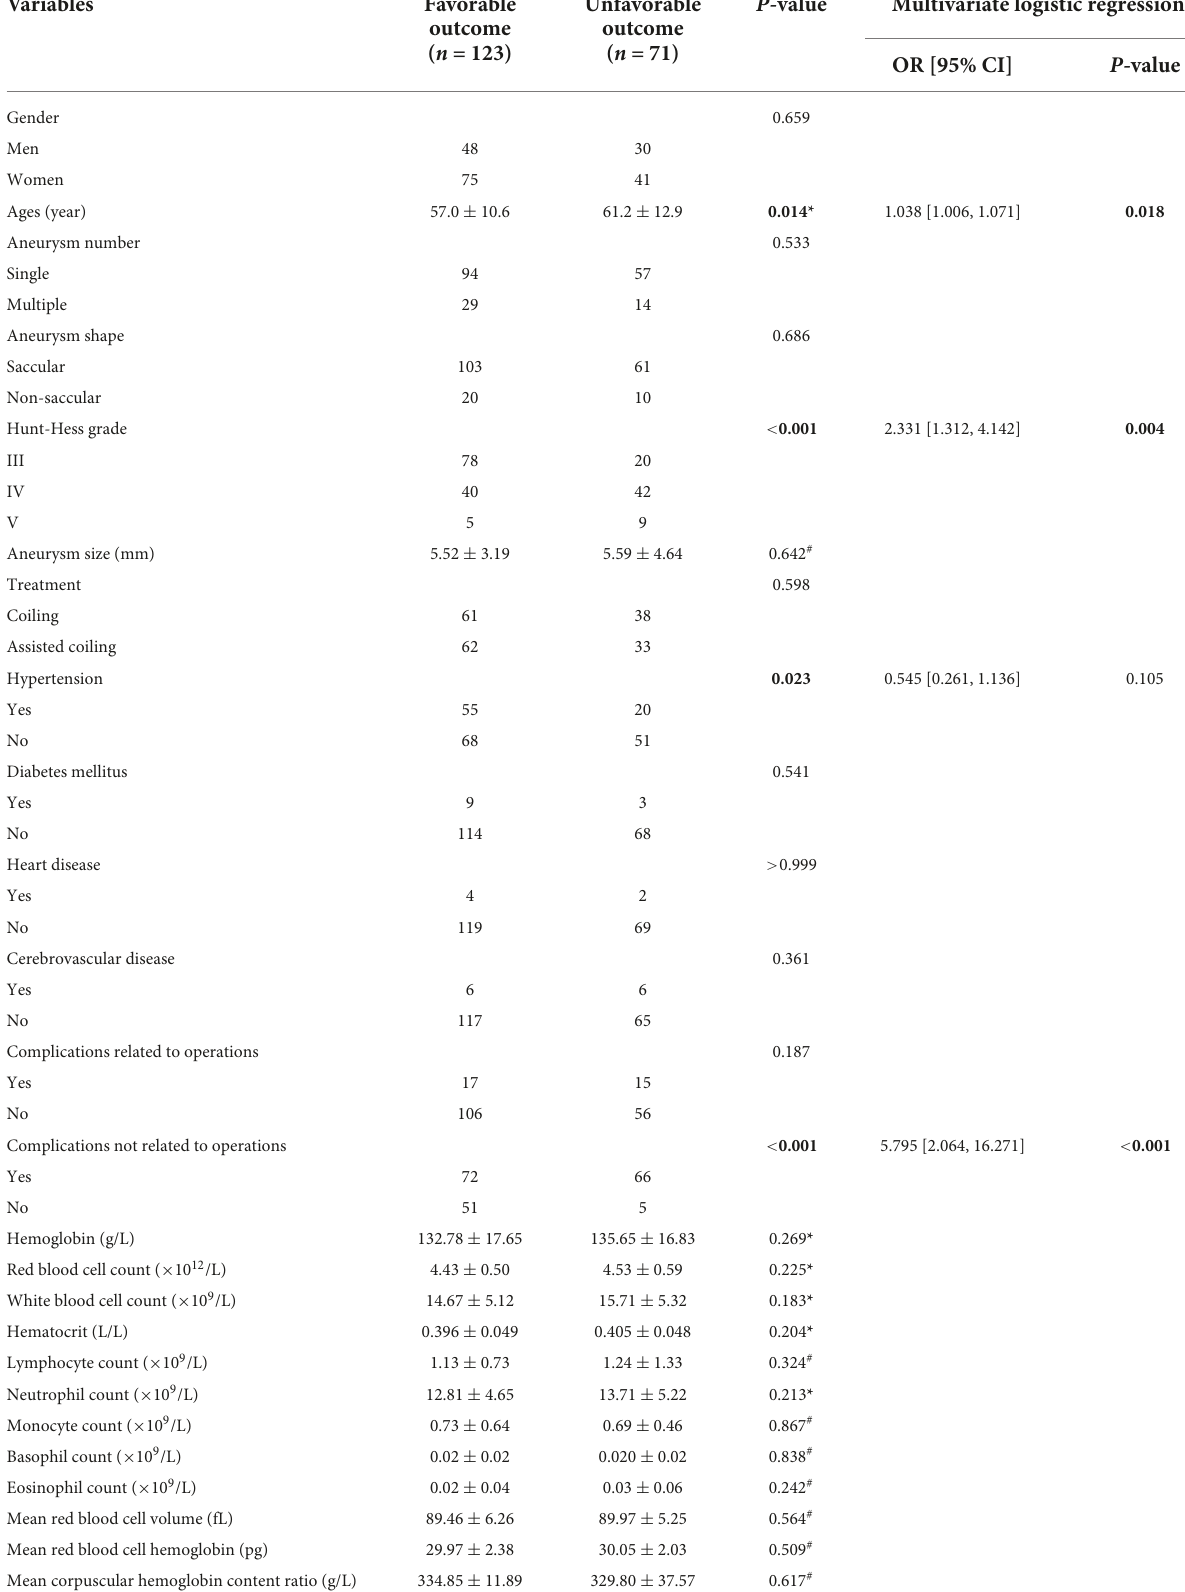
TABLE 1 Potential risk factors related to 6-month unfavorable outcomes in severe subarachnoid hemorrhage (SAH) patients. Variables Favorable